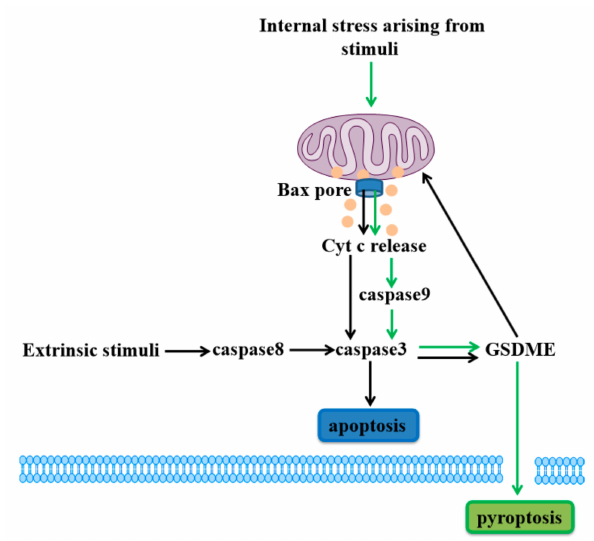
Figure 2. Gasdermin E (GSDME)-dependent cell death. Internal stress arising from stimuli (such as iron) lead to activation of Bax and release of Cyt c to stimulate caspase9 activation and induce caspase3 / GSDME-mediated cell pyroptosis (green arrows). Meanwhile, the extrinsic stimuli activate caspase8 and caspase3 to cleave GSDME, and GSDME permeabilizes the mitochondrial membrane to release Cyt c, inducing caspase3-mediated apoptosis (black